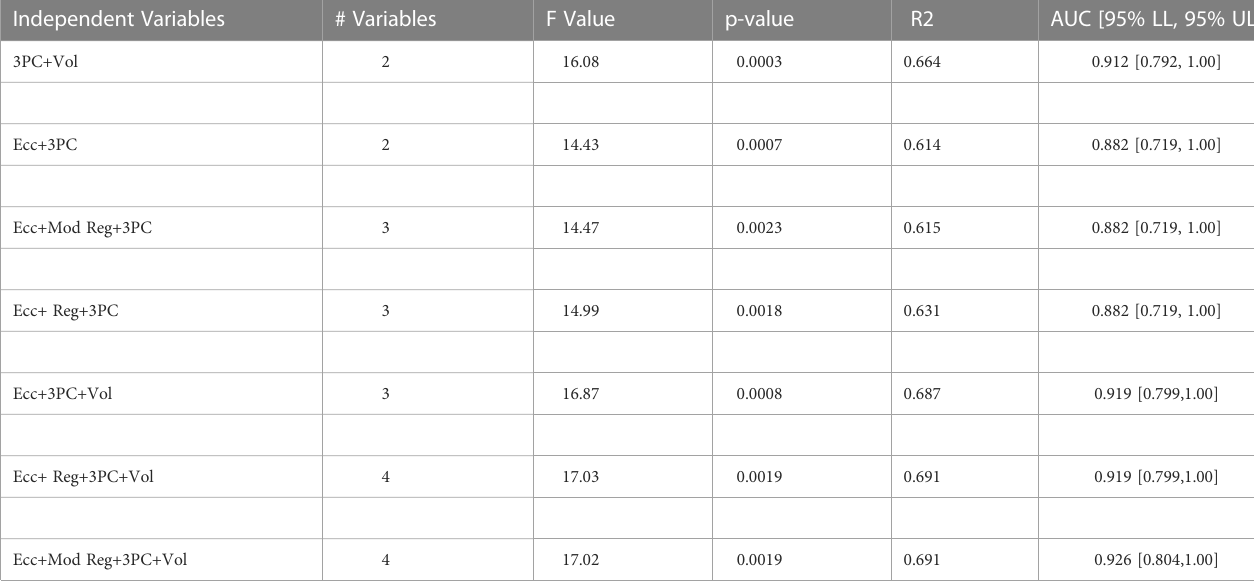
Analyzing all patients, Summary of Best Regression fi ts of combinations eccentricity, SCR, and Volume to Gleason score. AUC, Area Under Curve; R2, coef fi cient of determination; LL, Lower Limit Con fi dence Interval; UL Upper Limit 95% Con fi dence Interval; ECC, eccentricity(0.45 ACE Threshold); Mod_Reg, Modi fi ed Regularization; SCR, Reg, Regularized SCR; Vol, Volume (0.65 ACE